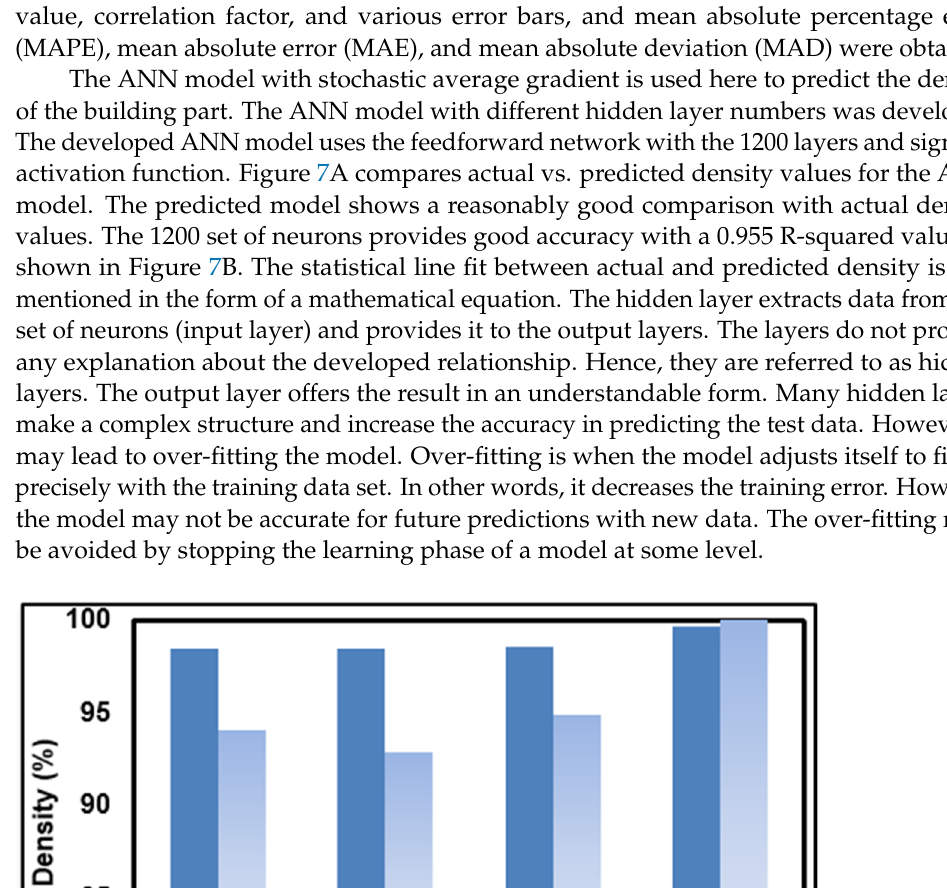
Figure 7. ANN model: ( A ) density prediction actual vs. predicted value and ( B ) statistical correla ‐ tion between actual vs. predicted value. The KNN model is also developed to predict density with 70% of training data. The KNN is an instant ‐ based learning model unusual from general explicit algorithms learn ‐ ing. KNN model is cross verified with the minimum RMSE value, and with the eight neighbors, the optimum value of RMSE was found to be 1.2331, as shown in Figure 8. The actual vs. predicted density value with the KNN model is compared as shown in Figure 9A. The predicted KNN model shows a sensibly good comparison with actual density values. The developed model accurately predicts the testing data set with a 0.863 R ‐ squared value, as shown in Figure 9B. The only limitation of the KNN model is the sensitivity to the unbalanced data set, where most entities belong to one or a few classes, and infrequent classes are often dominated in most neighborhoods. This can be alleviated through the balanced sampling of more popular classes in the training stage, possibly coupled with ensembles.